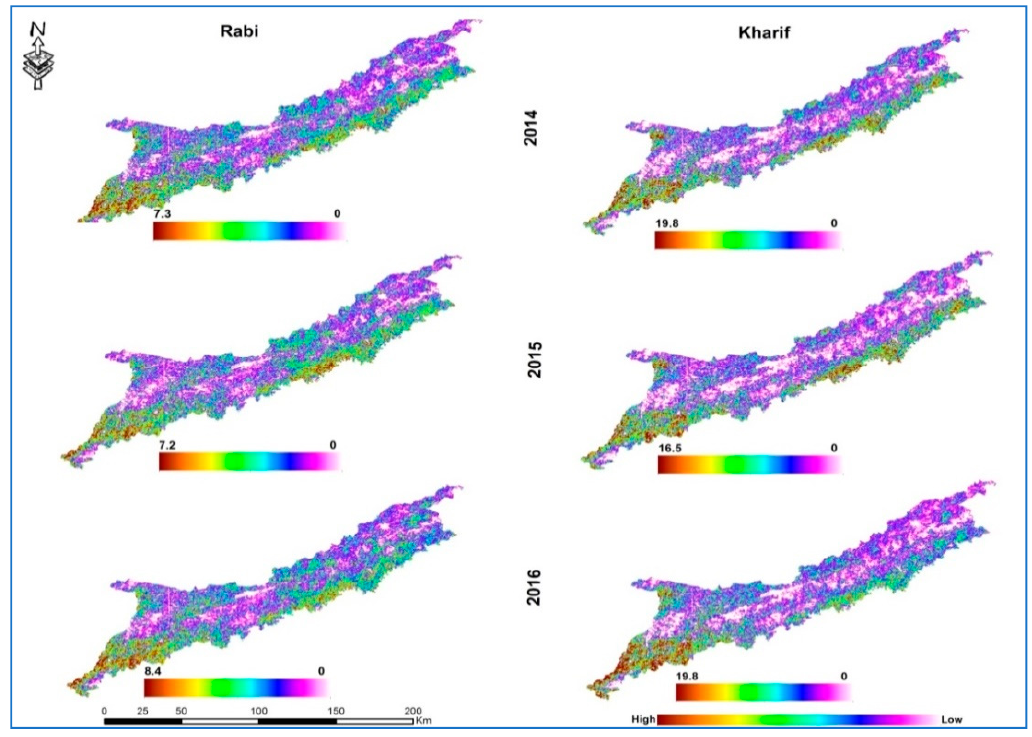
Figure 13. Season-wise spatial distribution pattern of water deficit.